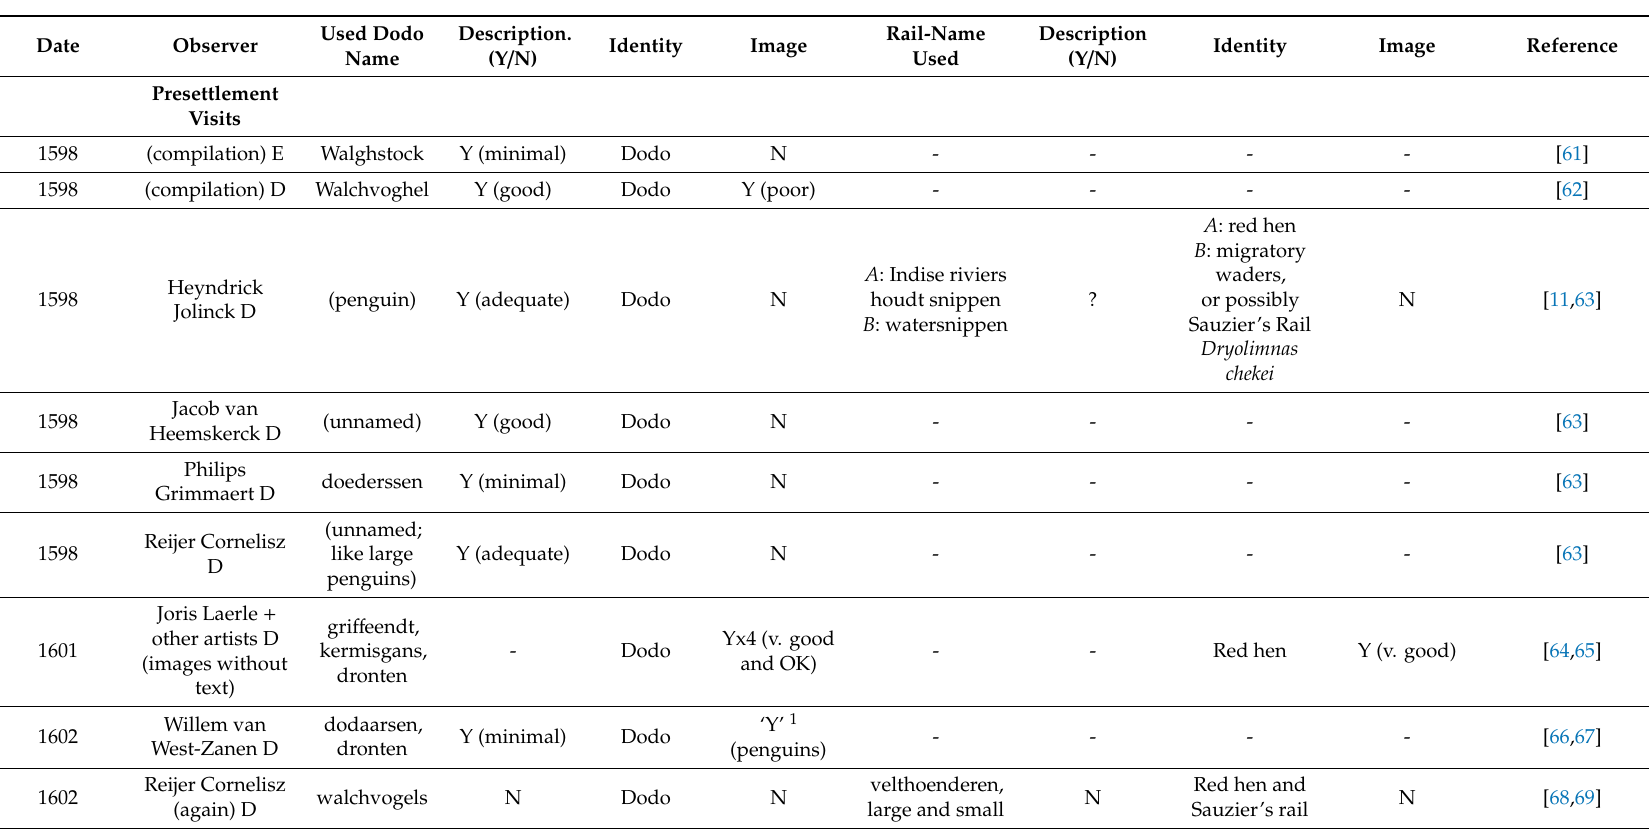
Table A1. Time series of all published dodo ( Raphus cucullatus ) and red hen ( Aphanapteryx bonasia ) records on Mauritius itself (birds seen elsewhere excluded), with indicated names and identities. Nationality (and hence language) of various observers: D = Dutch, E = English, F = French, G = German, P =